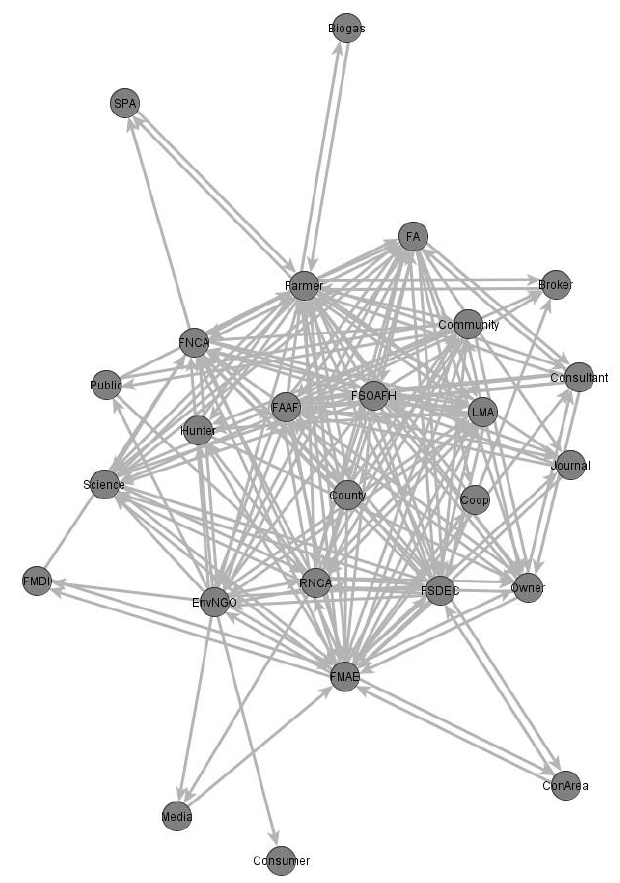
Figure A2.2. Regional network when three and more links between actors were mentioned